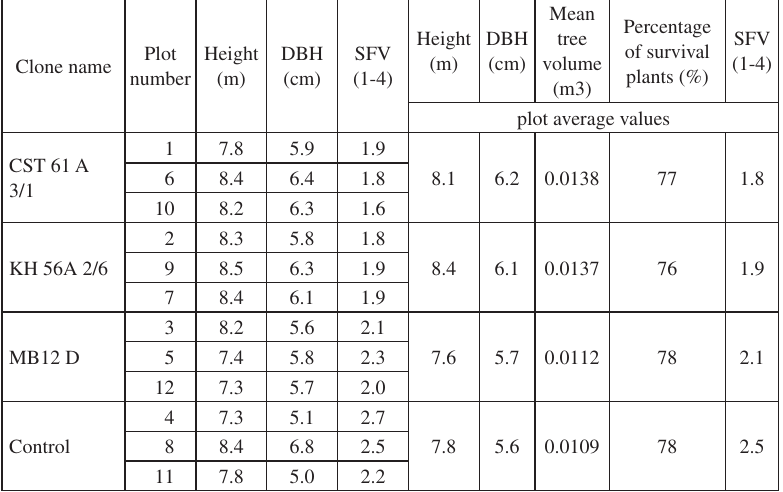
Table 1: Stand characteristics of micropropagated black locust clones at age of 7